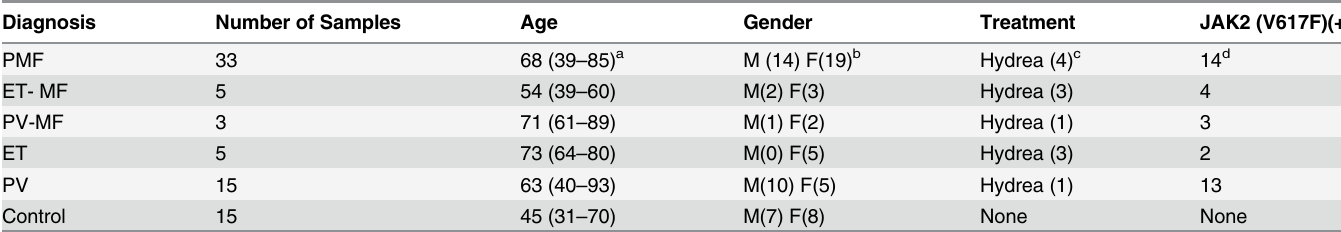
Table 1. Patient